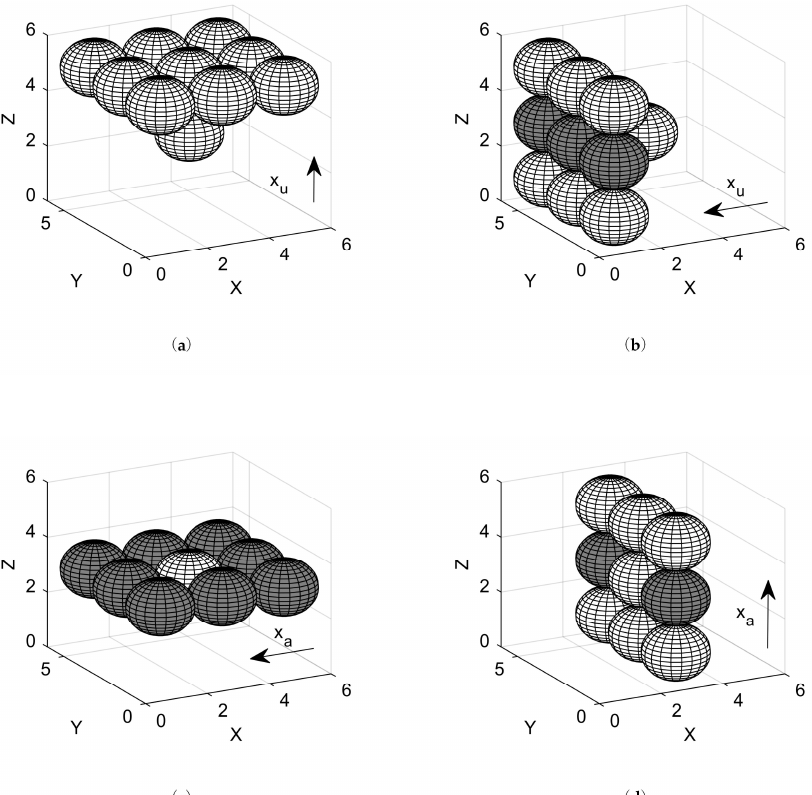
Figure A1. Influences of direction changes on the particle backscattering ratio x u and lateral scattering ratio x a . ( a ) when x u directs upward; ( b ) when x u directs laterally; ( c ) when x a directs laterally; ( d ) when x a directs upward. The radiation comes out from the central particle in the cube. The aggregation of particles in XOY is a sublayer. Grey balls are lateral particles in the same sublayer.